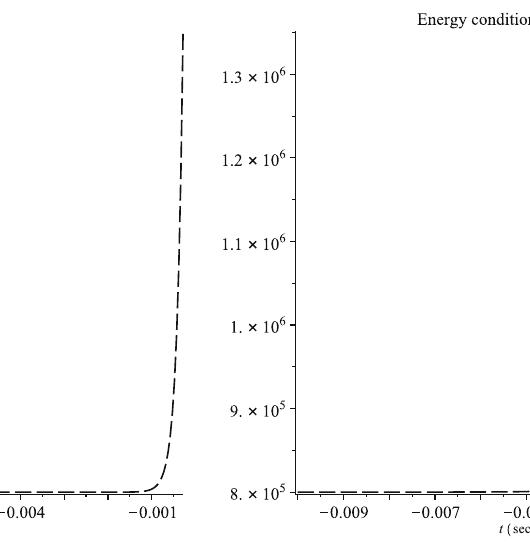
collapse process. Expressions in other energy conditions are dependent on these conditions, pressure and density which are all positive and hence other conditions may be satisfied as